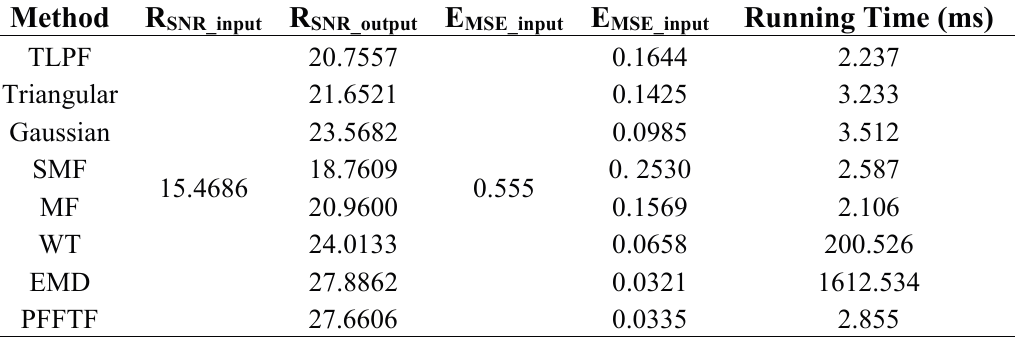
Table 1. The SNR, MSE and running time of different